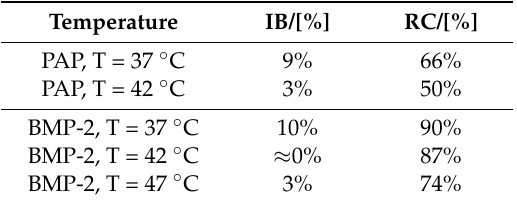
Table 6. Initial burst (IB) after 1h and residual content (RC) after 24 h of the release kinetics of PAP and BMP-2 from PNIPAM-DMAEMA/CS-1.2 coatings at HEPES buffer in dependence of temperature.